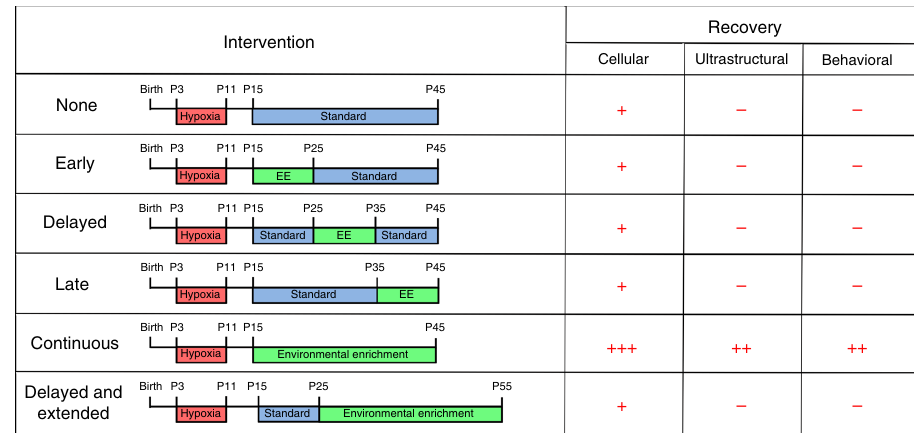
Fig. 6 Summary of cellular, ultrastructural, and behavioral recovery after perinatal brain injury using distinct neurodevelopmental paradigms of environmental enrichment. Alternative paradigms evaluated exposure to HX and subsequent EE after no intervention, early intervention (P15 − P25), delayed intervention (P25 − P35), late intervention (P35 − P45), or delayed and extended intervention (P25 − P55), with mice otherwise reared in standard laboratory housing.